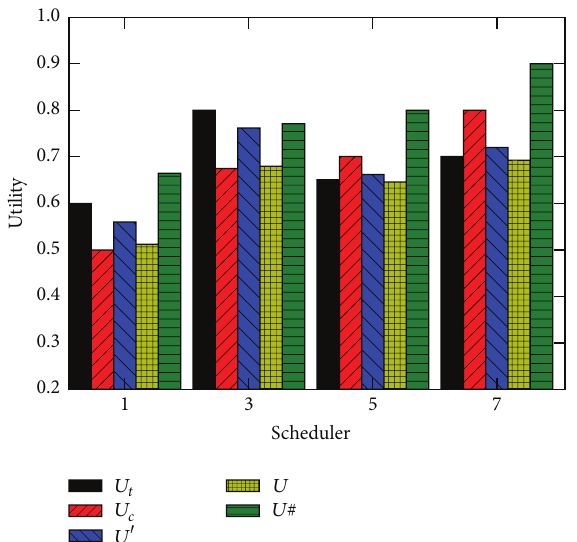
Figure 4: Utility distribution of time sensitive user tasks.